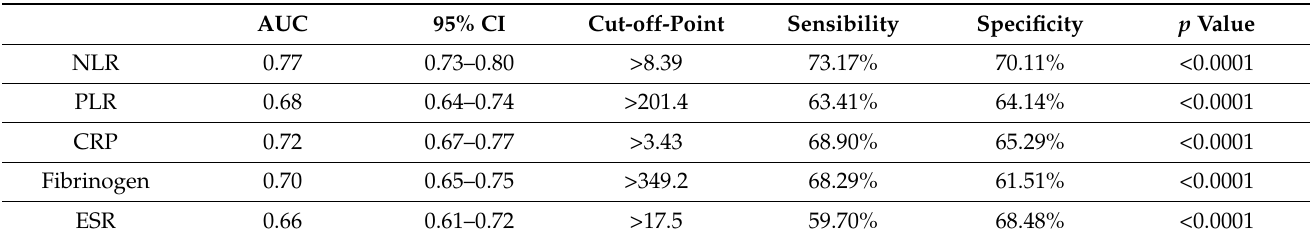
Table 3. ROC curves results of the novel biomarkers and inflammatory standard